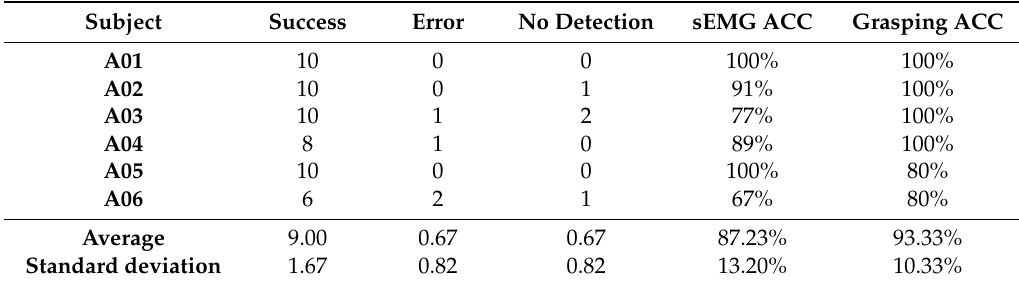
Table 1. sEMG performance and grasping accuracy for object position 1.